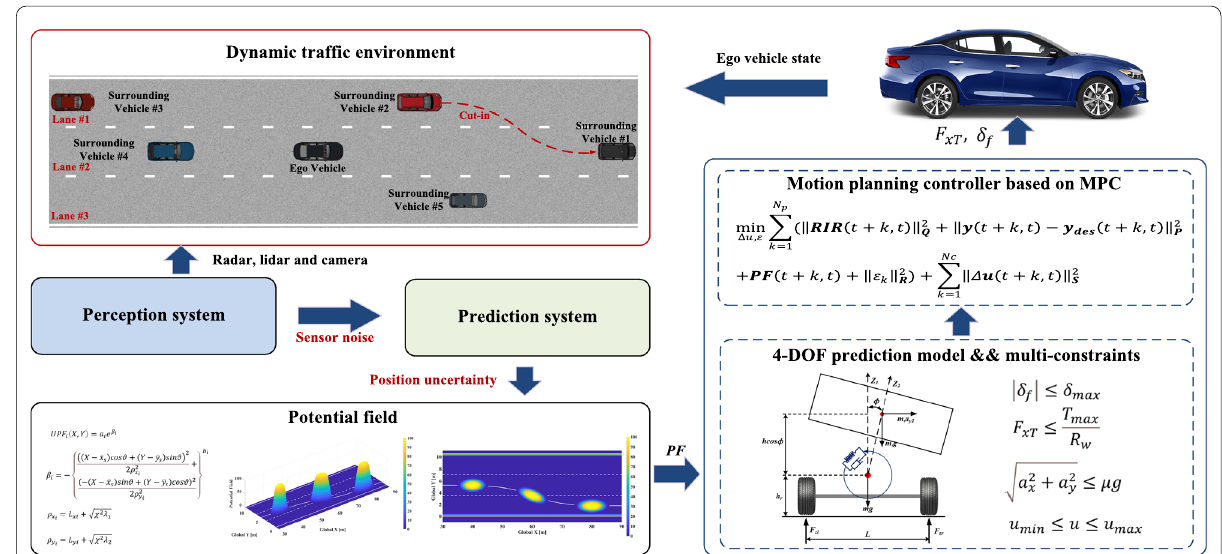
Figure 3 The overall structure of an environment uncertainty-aware motion planning framework for autonomous